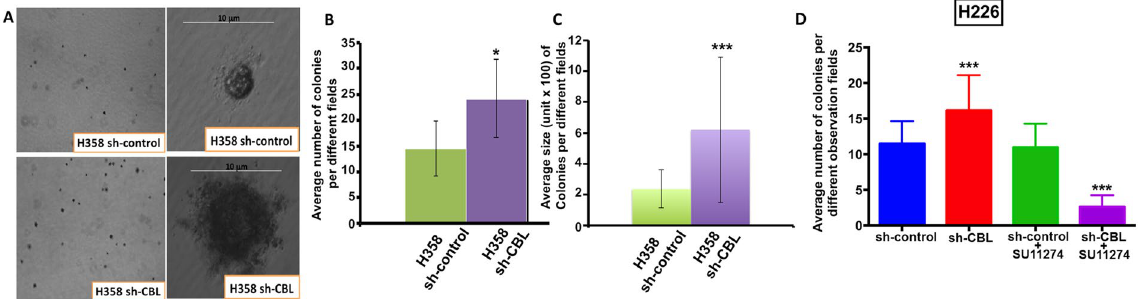
Figure 4. CBL knockdown increases colony formation and the cells were sensitive to MET inhibitor SU11274. ( A ) Soft agar colony formation assay showed colony formation of H358 sh-control and sh-CBL cells. sh-CBL cells showed more colonies and larger colony size than sh-control cells. ( B and C ) Show the colony number and size quantification respectively. (D) S oft agar colony formation assay showed colony formation of sh- CBL cells alone and treated with MET inhibitor SU11274 had significant more colonies and inhibition by SU11274 respectively than sh-control cells. P-values were for comparison with sh-control cells. ( * p < 0.05 and *** p <